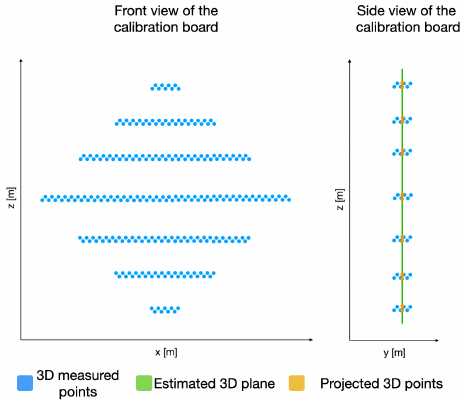
Figure 9. Acquired 3D points belonging to the calibration board and their projection on an estimated plane P . plane P